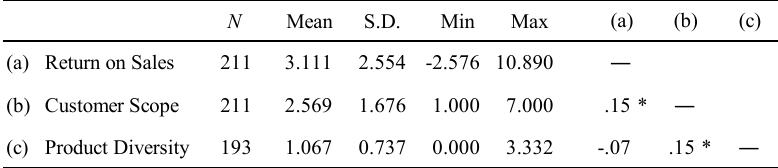
Table 1. Descriptive statistics and correlations of the variables